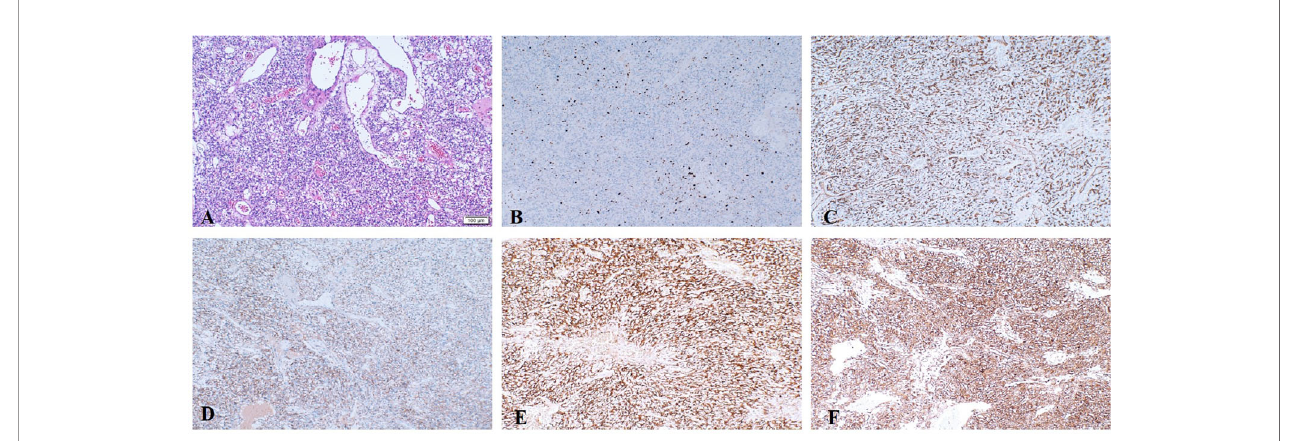
FIGURE 2 | Representative postoperative pathological images. (A) Histologic examination of optic nerve HGB. (B – F) Immunohistochemical staining. (B) The proliferative fraction of tumor cells (Ki-67) was low, at approximately 2%. (C) CD-34 showed abundant blood vessels. Tumor cells showed positivity for EGFR (D) , NSE (E) and vimentin (F) .